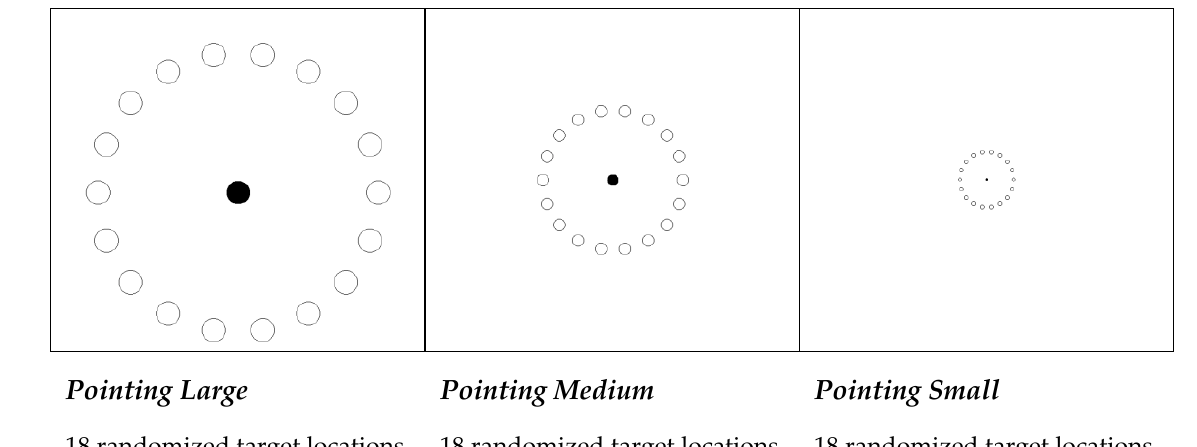
Figure 10. Pointing (and clicking) test tasks.